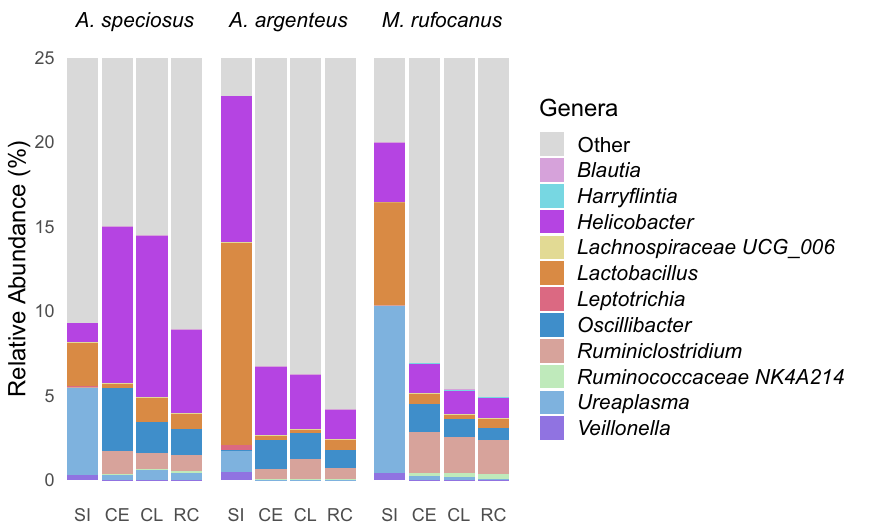
Figure 5. Relative abundances of bacterial genera exhibiting either a similar trend along the GIT of all three rodent species or a species-specific trend. SI small intestine, CE cecum, CL colon, and RC